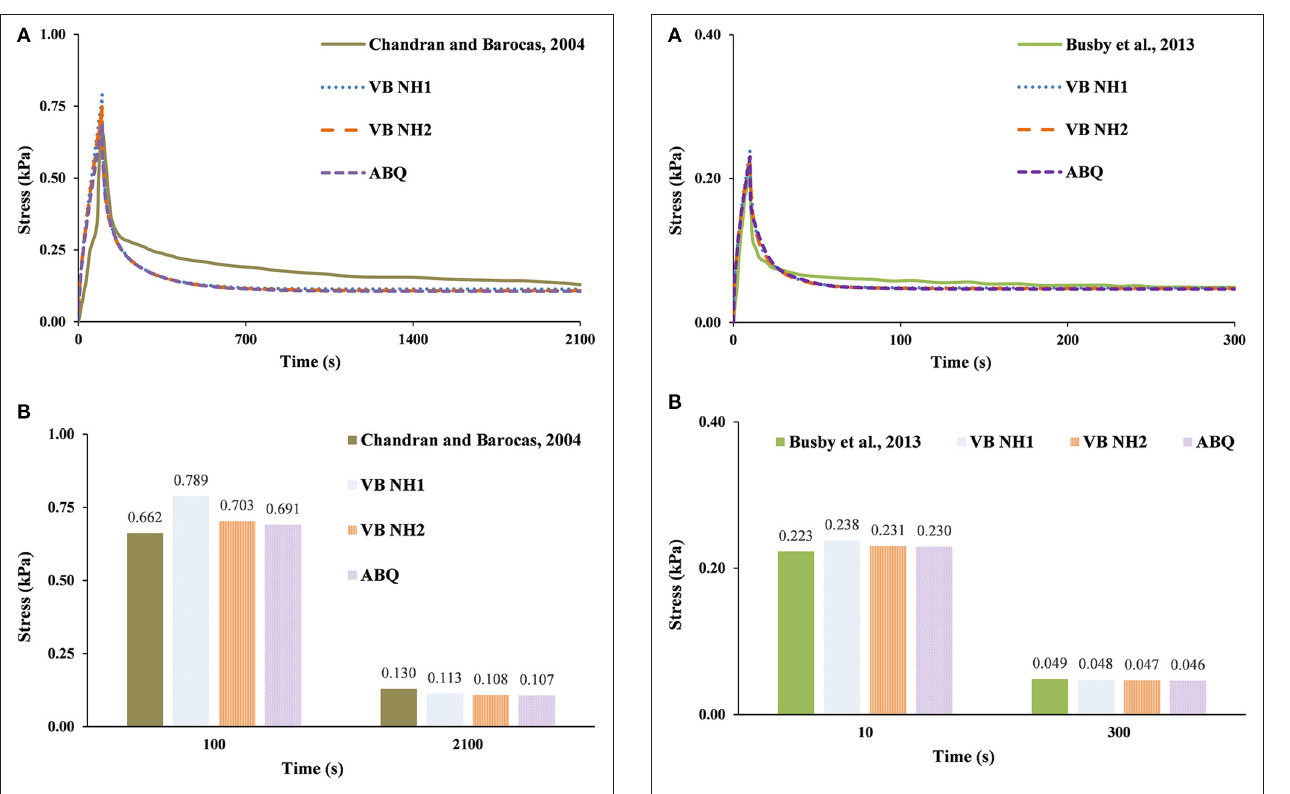
FIGURE 3 | 0.30% collagen hydrogel during 2,100s stress relaxation test. The experimental data of Chandran and Barocas (2004) is here compared with numerical calculations using V-Biomech and Abaqus: (A) Stress relaxation over time; (B) Peak and end effective stress values.